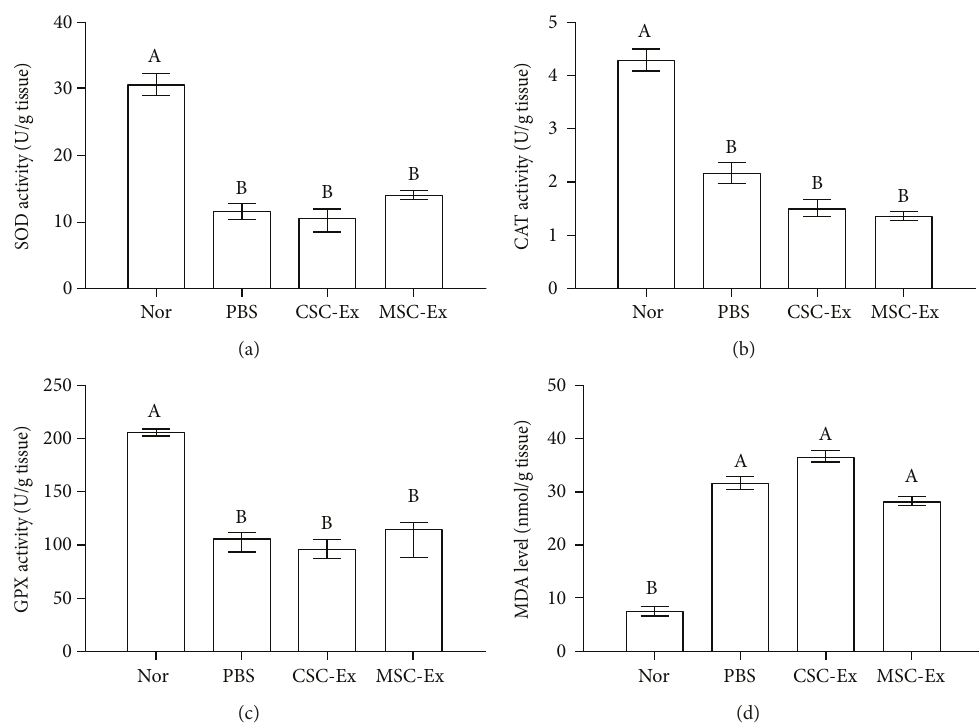
Figure 4: Antioxidant/ROS status of HCC rats after treatment by exosomes derived from CSCs and MSCs showed unchanged levels of MDA, SOD, CAT, and GPX in the liver. Values are expressed as mean ± SEM ( n = 9/group ). Di ff erent letters on columns mean signi fi cant di ff erence at P < 0 0001 .